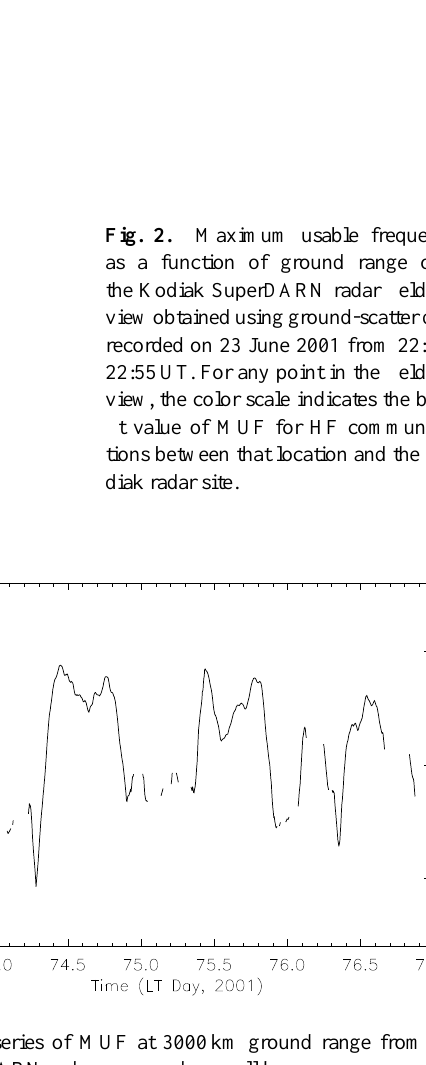
Fig. 3. Time series of MUF at 3000km ground range from the Kodiak SuperDARN radar, averaged over all